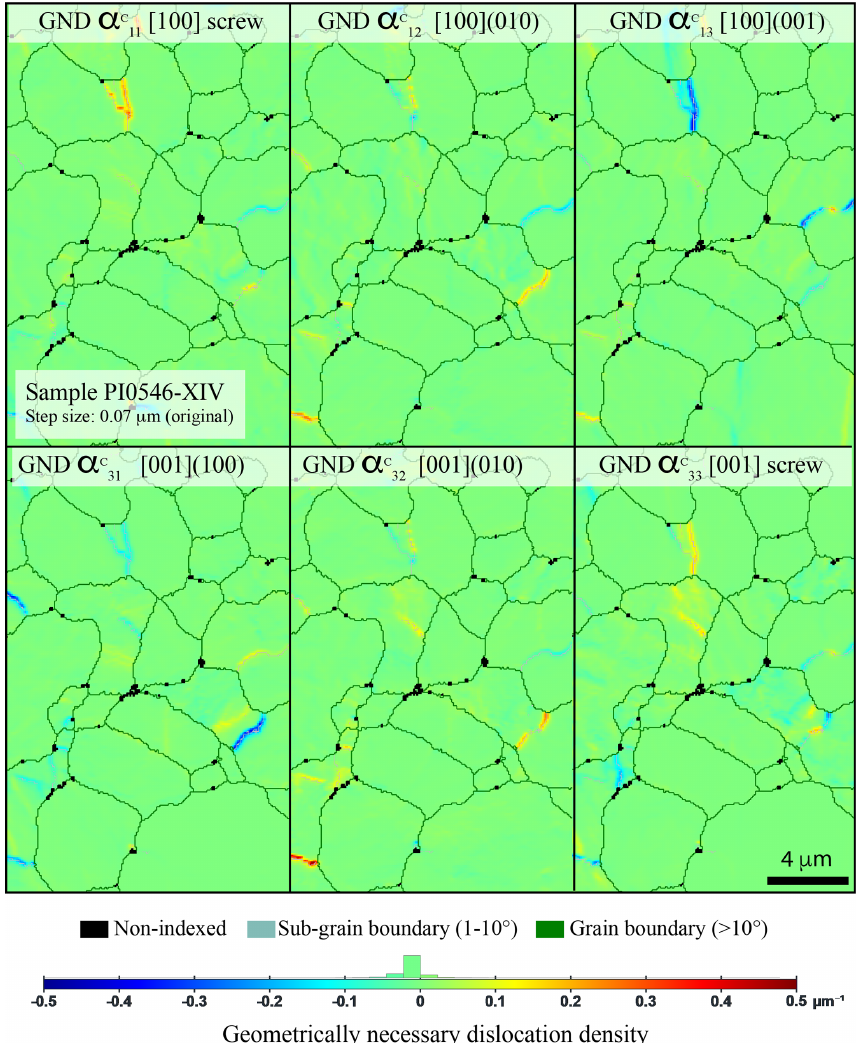
Figure 5. Representative distribution of the different GND densities reported in the crystallographic frame (noted α c ) in the sample deformed in torsion (PI0546-XIV). The density scale is automatically set up for this set of maps; the step size was 0.07µm (original acquisition step size), and the smoothing factor was